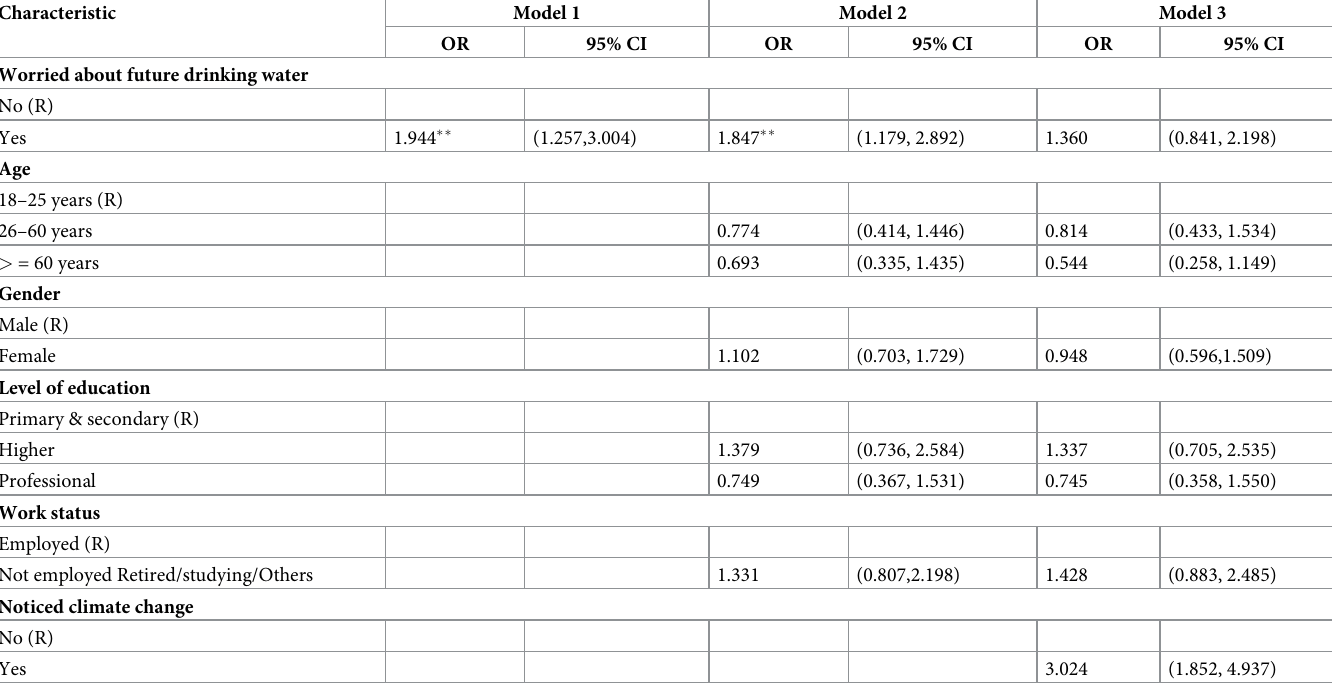
change variable (Table 3, Model 3) reduced the perception of water scarcity odds ratio for pre- tically insignificant, implying that acknowledgment of climate change mediates the association of water scarcity with support for alternative water sources. Table 3. Logistic regression results showing odds ratios (OR) and their 95% confidence intervals (CI) predicting support to alternative potable water sources.